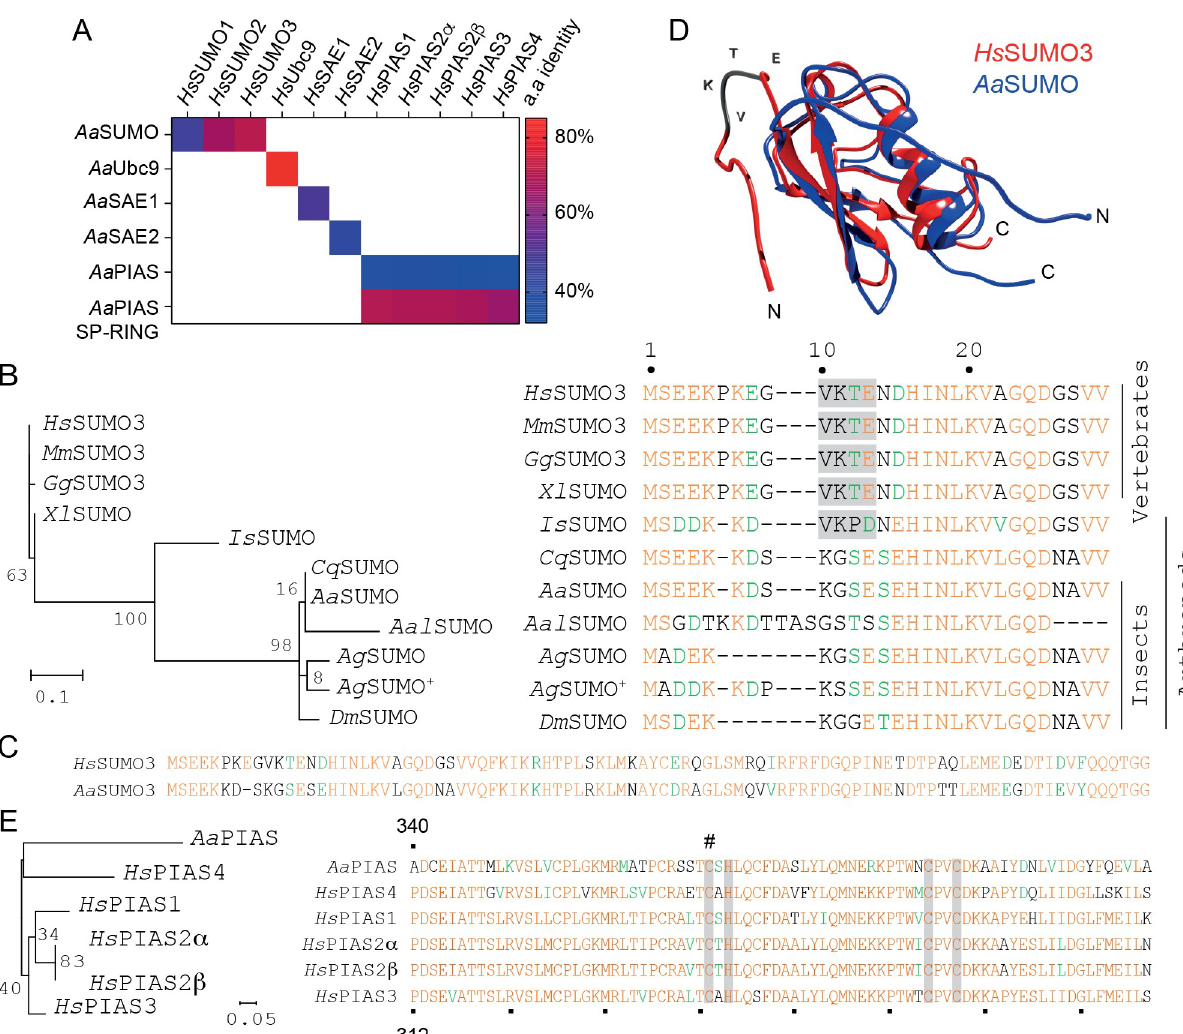
Aa SAE2, and Aa Ubc9 shared 42%, 50%, and 85% amino acid identity with their respective H . sapiens orthologues (Fig 1A). Homology between Aa SUMO and Hs SUMO1-3 proteins ranged from 47 to 71% identity, with Aa SUMO showing the highest degree of similarity to that of Hs SUMO3 (Fig 1A). Phylogenetic alignment of SUMO proteins from different species